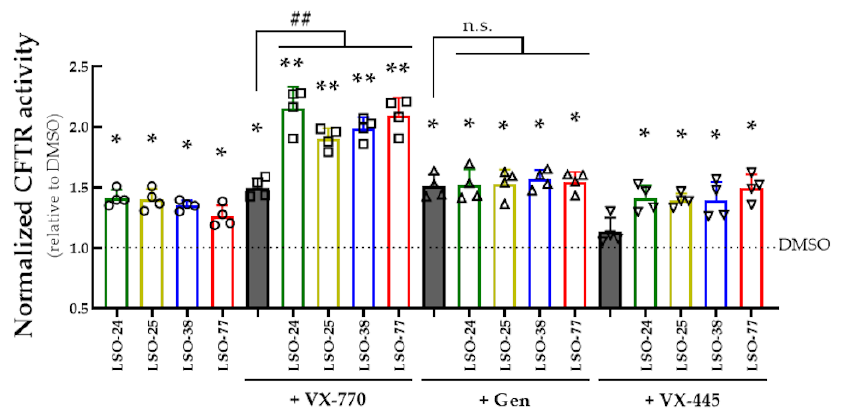
Figure 5. Assessment of additivity of potentiators activity on R334W-CFTR function in a cell line. CFBE cells co-expressing R334W-CFTR and the HS-YFP were acutely stimulated (30 min) with Fsk (5 µ M) plus test compounds (individually or in combination): LSO-24 (5 µ M); LSO-25 (5 µ M); LSO-38 (5 µ M); LSO-77 (10 µ M); VX-770 (1 µ M); Gen (50 µ M); and VX-445 (3 µ M). CFTR function was assessed based on the cell-fluorescence quenching rate and normalized to the negative control (DMSO). Data are represented as means + SD: * p < 0.05 and ** p < 0.01 vs. DMSO. Other symbols indicate the statistical significance of groups of data vs. VX-770 alone: ## P < 0.01; n.s. — not significant.